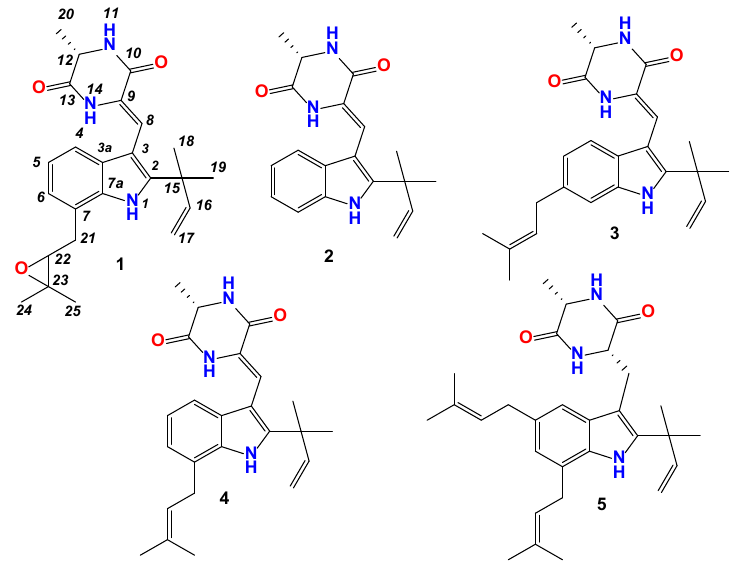
Figure 7. Structures of compounds 1 – 5 isolated from spore. Compound 1 was isolated as a light yellow amorphous powder. The molecular formula of 1 was determined to be C 24 H 29 N 3 O 3 based on its high-resolution electrospray ionization mass spectrum (HR-ESIMS) ( m / z [M + H] + 408.2289, calculated for C 24 H 30 N 3 O 3 , 408.2289), accounting for 12 degrees of unsaturation (Figure S1). The 1 H, 13 C and HSQC NMR spectra of 1 (Figures S3–S5, Table 1) showed the presence of one doublet methyl group [ δ H 1.60/ δ C 21.0 (20-Me)], four singlet methyl groups [ δ H 1.55/ δ C 27.4 (18-Me), δ H 1.55/ δ C 27.5 (19-Me), δ H 1.51/ δ C 19.2 (C-24), δ H 25.0/ δ C 140 (C-25)], one sp 3 methylene group [ δ H 3.24 and 2.92/ δ C 33.7 (C-21)], one sp 3 oxygenated methine [ δ H 3.01/ δ C 64.4 (C-22)], one 1,2,3-trisubstituted benzene moiety [ δ C 126.3 (C-3a), δ H 7.19 (d, 8.0)/ δ C 117.8 (C-4), δ H 7.08 (dd, 8.0, 8.0)/ δ C 121.1 (C-5), δ H 6.99 (8.0)/ δ C 122.7 (C-6), δ C 122.2 (C-7), δ C 134.2 (C-7a)], one terminal double bond [ δ H 6.07/ δ C 144.3 (C-16), δ H 5.15 and 5.17/ δ C 112.9 (C-17)], one olefinic double bond [ δ H 7.22/ δ C 112.7 (C-8), δ C 112.4 (C-9)], one sp 3 oxygenated quaternary carbon [ δ C 60.4 (C-23)], two sp 2 quaternary carbons [ δ C 144.6 (C-2), δ C 103.2 (C-3)], as well as two carbonyl carbons [ δ C 160.1 (C-10), δ C 165.8 (C-13)]. All these data indicated that compound 1 owns a skeleton of indole-containing diketopiperazine alkaloids. 1 H- 1 H COSY spectrum (Figure 8 and Figure S6) indicated the moieties of C- 4/C-5/C-6, C-12/C-20, and C-21/C-22. In the HMBC spectra, the correlations from H-4 to C-3, C-6, and C-7a, from H-6 to C-7a, from H-NH-1 to C-2, C-3, and C-3a confirmed the indole moiety. The long range HMBC crossing peaks from H 3 -18 and H 3 -19 to C-2, C-15, and C-16 revealed the isopentene moiety (C15/C16/C17/C18/C19) and the connection between C-2 and C-15. The methyl diketopiperazine and the linkage between C-3 and C-8 were suggested by the HMBC correlations from H 3 -20 to C-12 and C-13, from H-NH-14 to C-8, C-9, C-10, C-12, and C-13, and from H-8 to C-2, C-3a, and C-10. The oxygenated side chain was indicated by the HMBC correlations from H 3 -24 and H 3 -25 to C-22 and C-23. C-21 attachment to C-7 was revealed by the HMBC correlations from H-6 to C-21 and from H-21 to C-6, C-7, and C-7a. Combined with molecular formula and chemical shifts for C-22 ( δ C 64.4) and C-23 ( δ C 60.4), there should be an epoxy bond between C-2 and